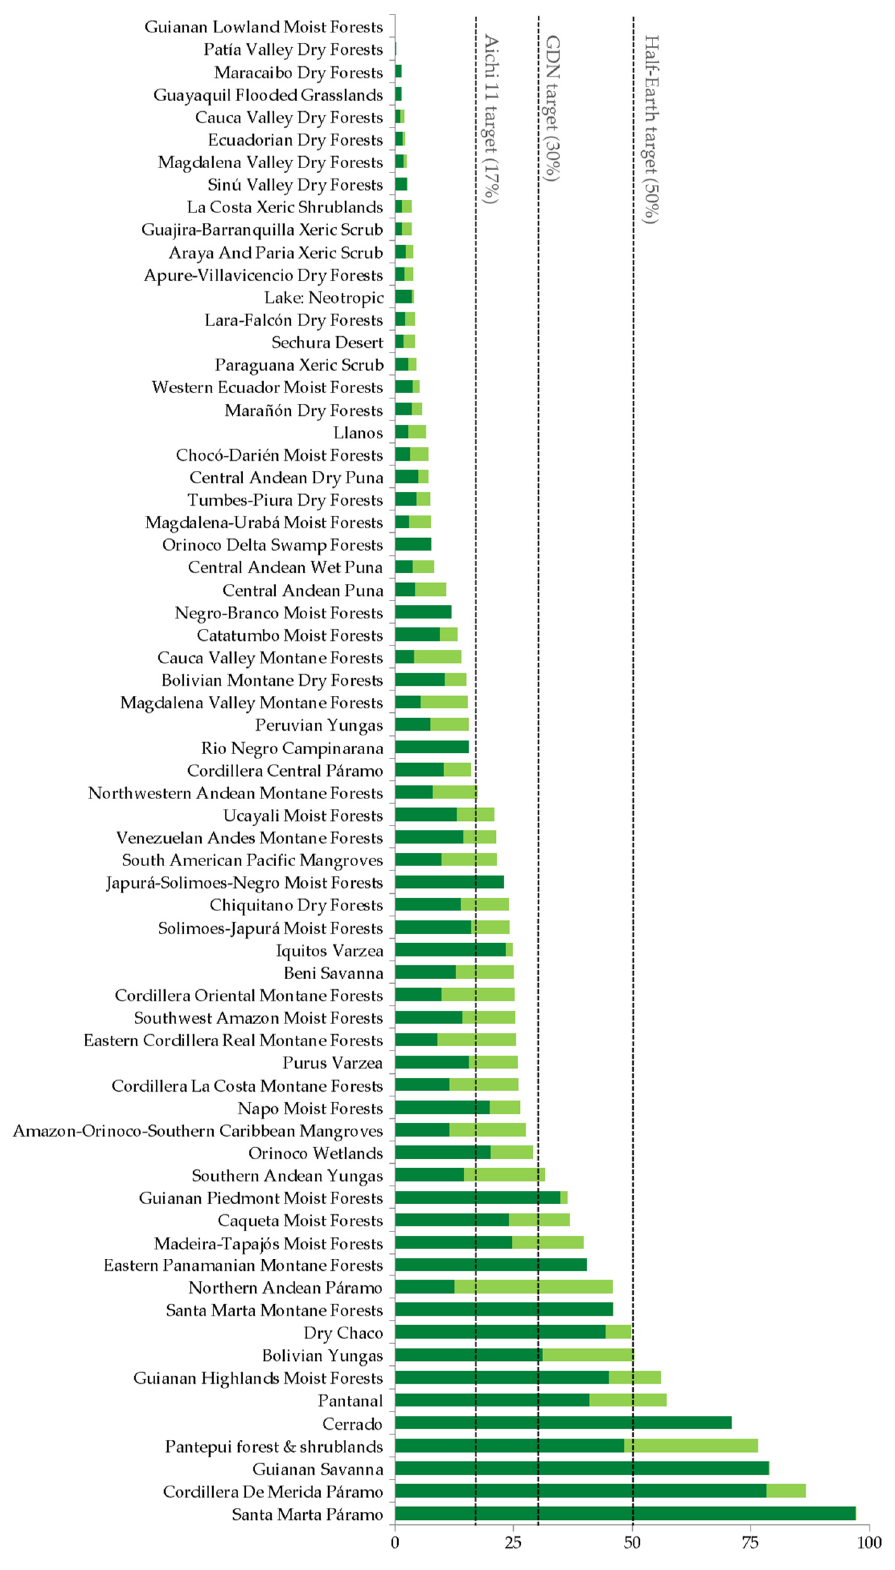
Figure 2. TAC Ecoregion’s coverage (%) of protected areas (dark green: protected and connected land— ProtConn CD , and light green: protected but not connected land— ProtUnconn CD ). d med = 10 km. Prot = ProtConn CD + ProtUnconn CD. Global targets (17%, 30%, and 50%) are marked in dotted lines.